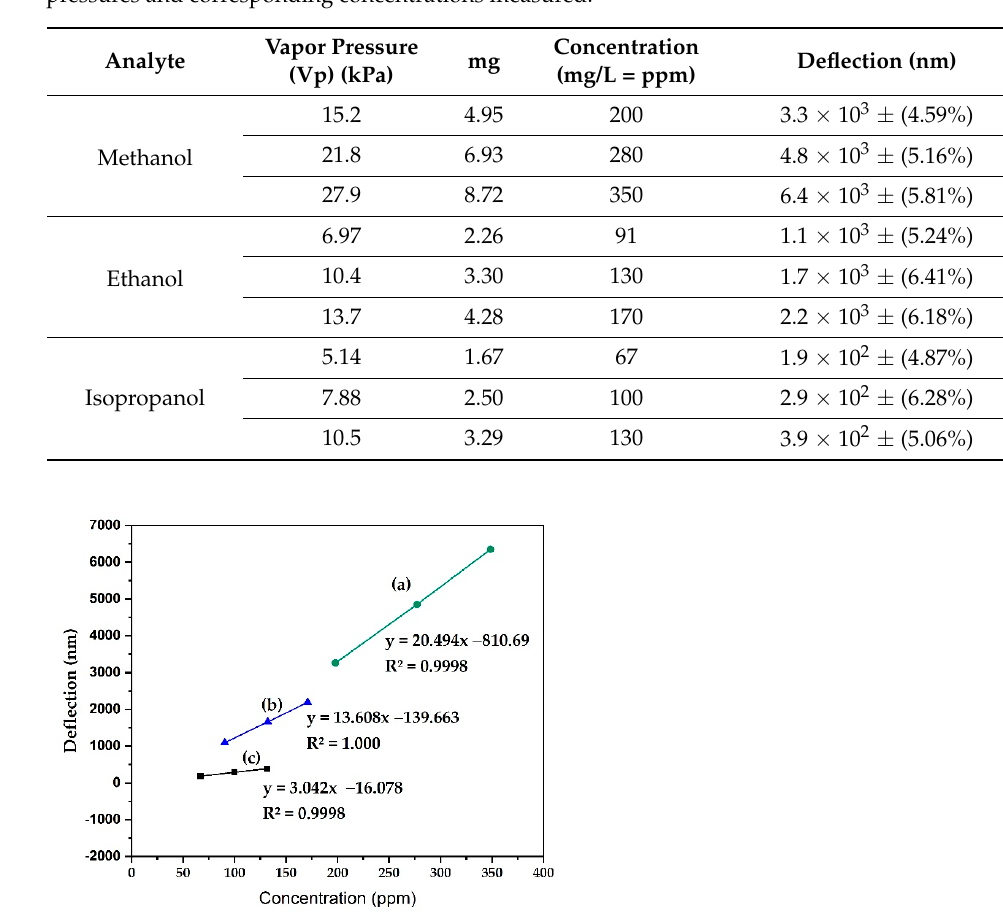
Figure 3. Microcantilever deflection versus time profiles for the different concentrations of ( a ) methanol, ( b ) ethanol, and ( c ) isopropanol vapors. Table 1. Microcantilever deflection values at 580s for the alcohol vapor analytes at the different vapor pressures and corresponding concentrations measured.